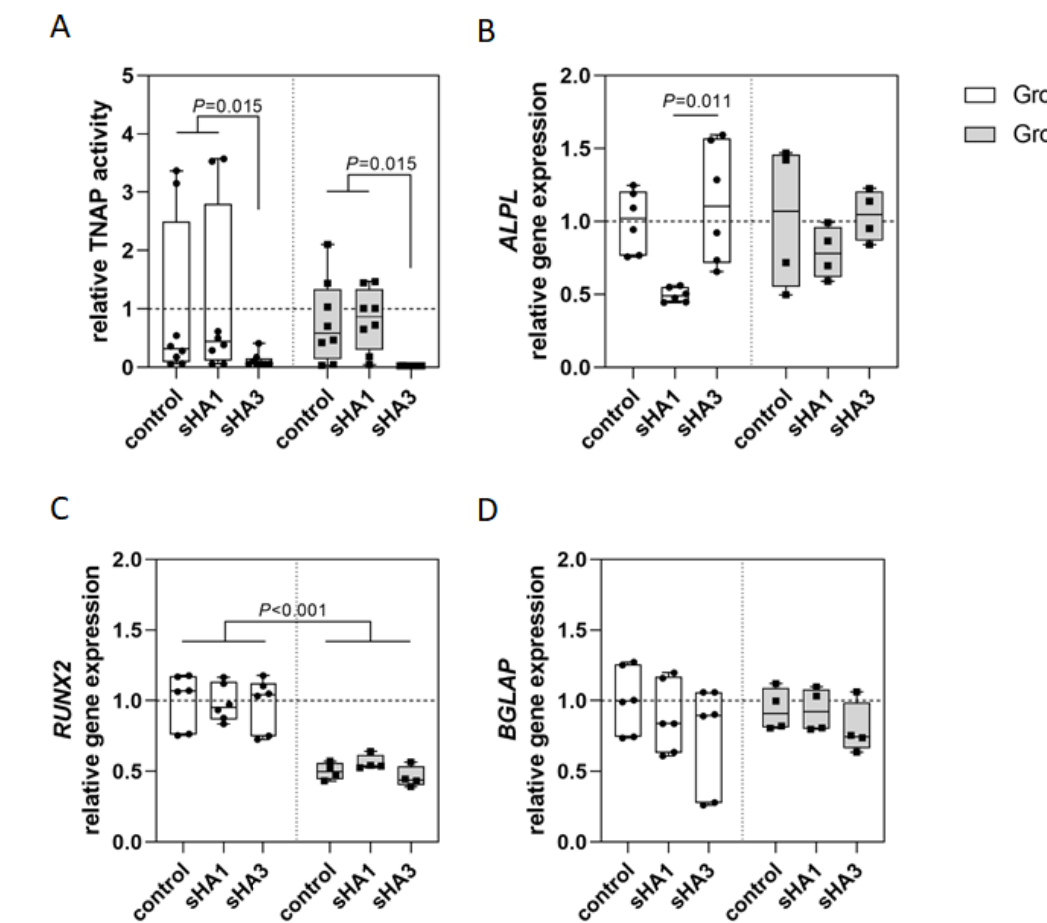
Figure 5. Impact of sHA on osteoblasts after 14 days of sHA treatment. ( A ) TNAP activity was quantified in cells of eight patients per group. The untreated control of group A was set to 1. TNAP activity was reduced significantly after sHA3 treatment. Expression of the osteogenic marker genes ALPL ( B ), RUNX2 ( C ) and BGLAP ( D ) was evaluated by quantitative real-time PCR. Gene expression of the target genes was normalized to GAPDH expression and calculated using the CT method. Data are shown as median with interquartile range and min/max values, statistical analyses were performed using ANOVA and Tukey post-hoc test.